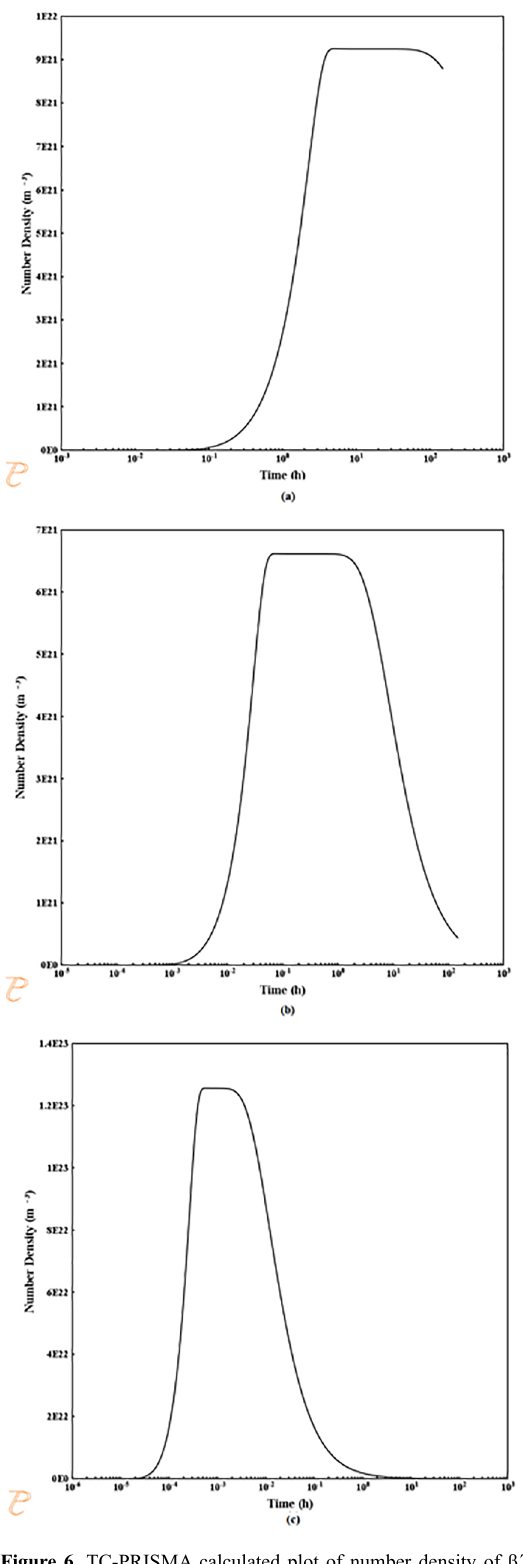
Figure 6. TC-PRISMA calculated plot of number density of β´ precipitate versus time for Cu-4wt.%Ti alloy aged at (a) 400 ºC, (b) 500 ºC and (c) 600 ºC.